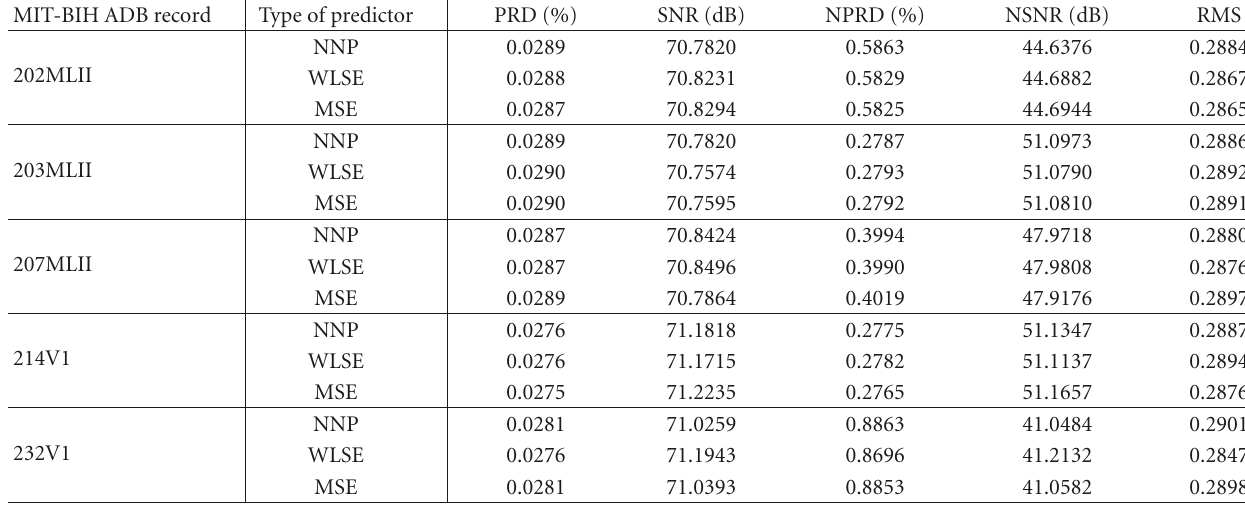
Table 6: Quality performance results: comparison between NNP- and LP-based compression schemes on short-duration datasets. NNP: neural network predictor, WLSE denotes weighted least-squares error linear predictor, and MSE denotes mean-square error linear predictor.